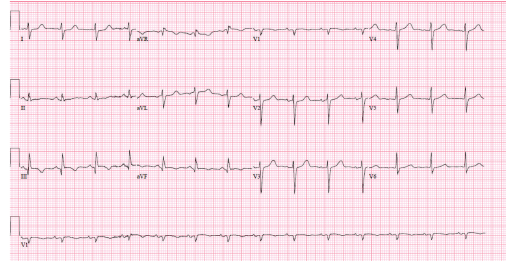
Figure 2: EKG on day 3 of admission shows normal sinus rhythm with significant resolution of QTc